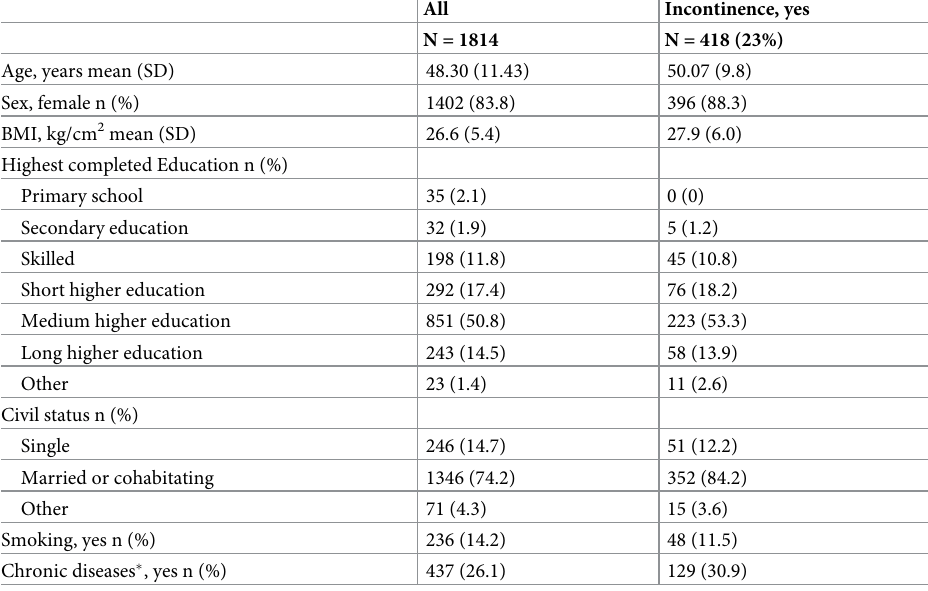
Table 1. Baseline demographics.